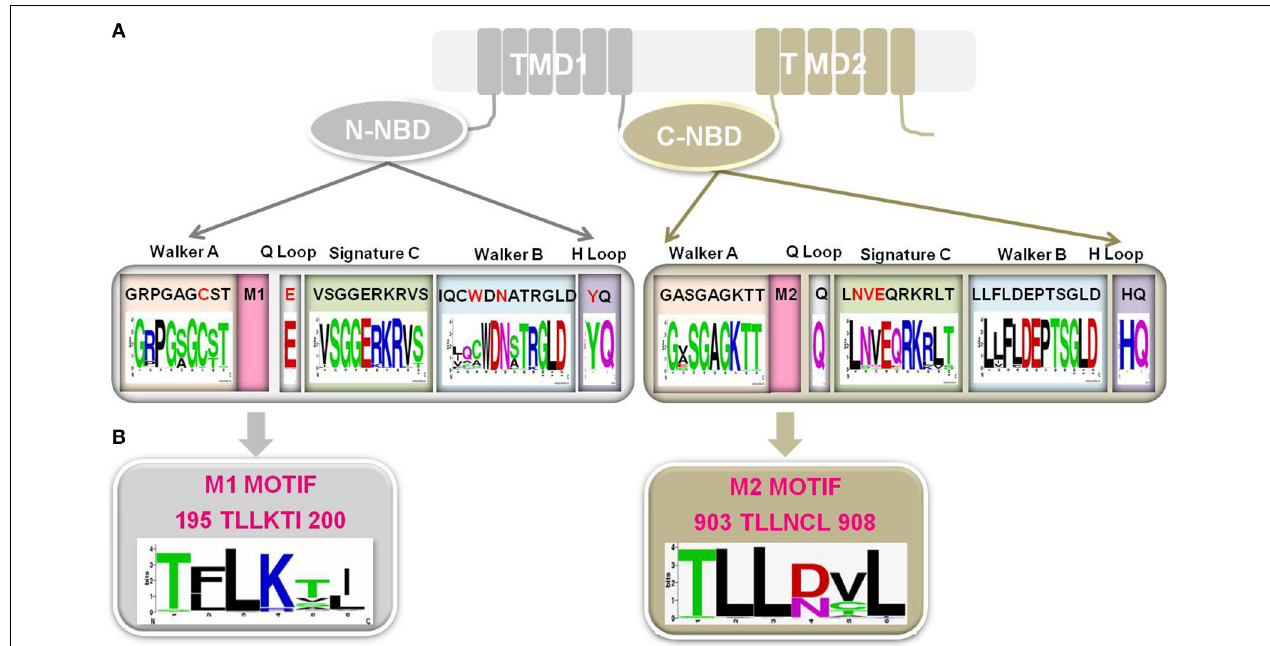
FIGURE 4 | (A) Schematic representation of Cdr1p, wherein N-NBD showing degeneracy (red typeface) in conserved Walker A motif, Walker B motif, Q loop and H loop while C-NBD showing degeneracy in signature C. The sequences shown for each motif is from Cdr1p. Sequences of 85 Fungal PDR transporters having topology similar to Cdr1p (Rawal et al., 2013) have been used for the consensus panels below the motif sequences. Sequence conservation of NBD motifs among fungal PDR transporters is individually depicted by Sequence logos, which are a graphical representation of an amino acid multiple